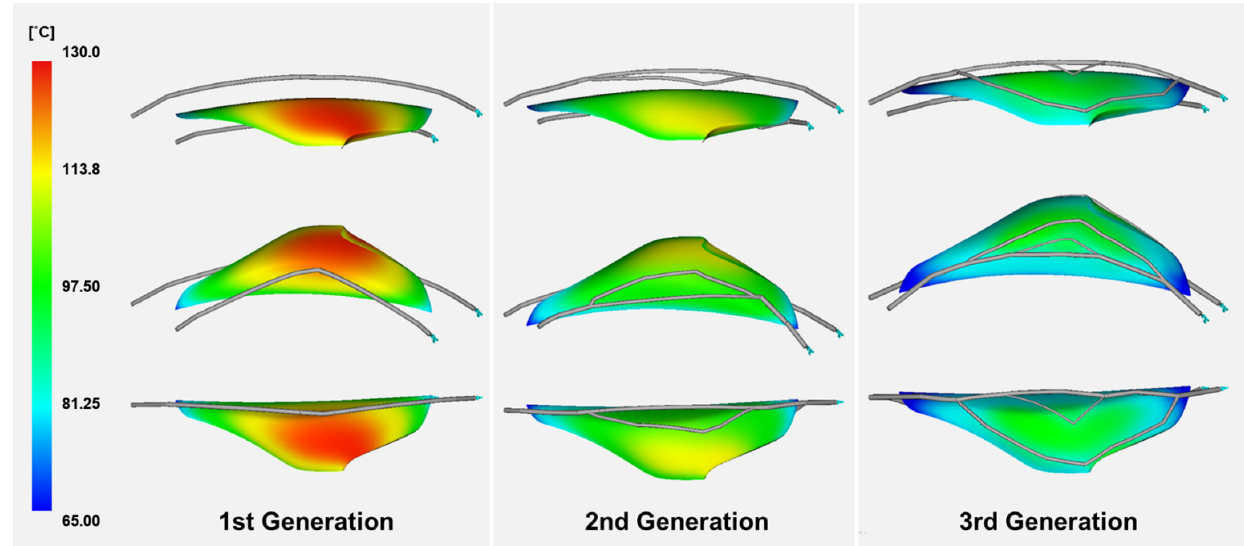
Figure 11. Part temperature results through the evolution